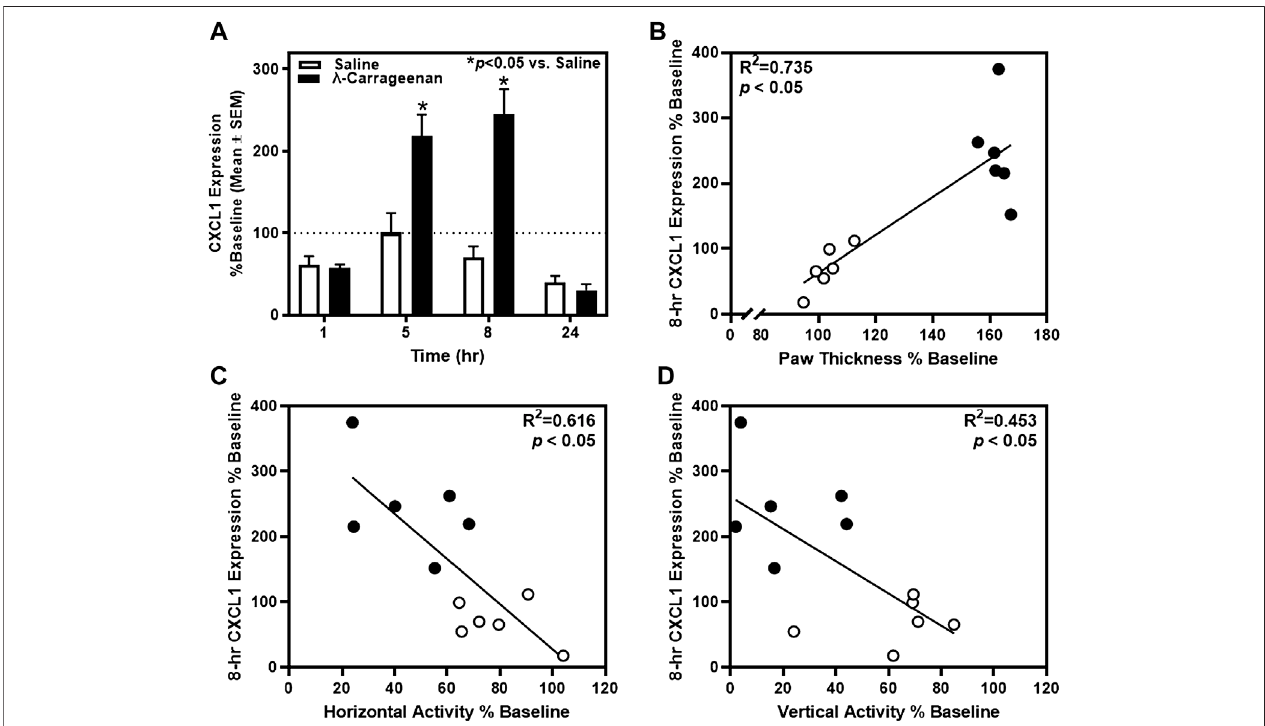
FIGURE 4 | The impact of λ -carrageenan on the timecourse of CXCL1 expression is presented with correlational analyses. (A) The percent baseline CXCL1 expression wascalculated asthemeanvalue at each time pointfollowingtreatmentwithsaline (white bars)or λ -carrageenan(black bars), normalizedtobaseline values. λ -Carrageenan signi fi cantly increased CXCL1 expression relative to saline at 5 and 8 h (* p < 0.05 vs. saline). (B) CXCL1 expression positively correlated with paw thickness and negatively correlated with (C) horizontal and (D) vertical activity at the 8 h timepoint.